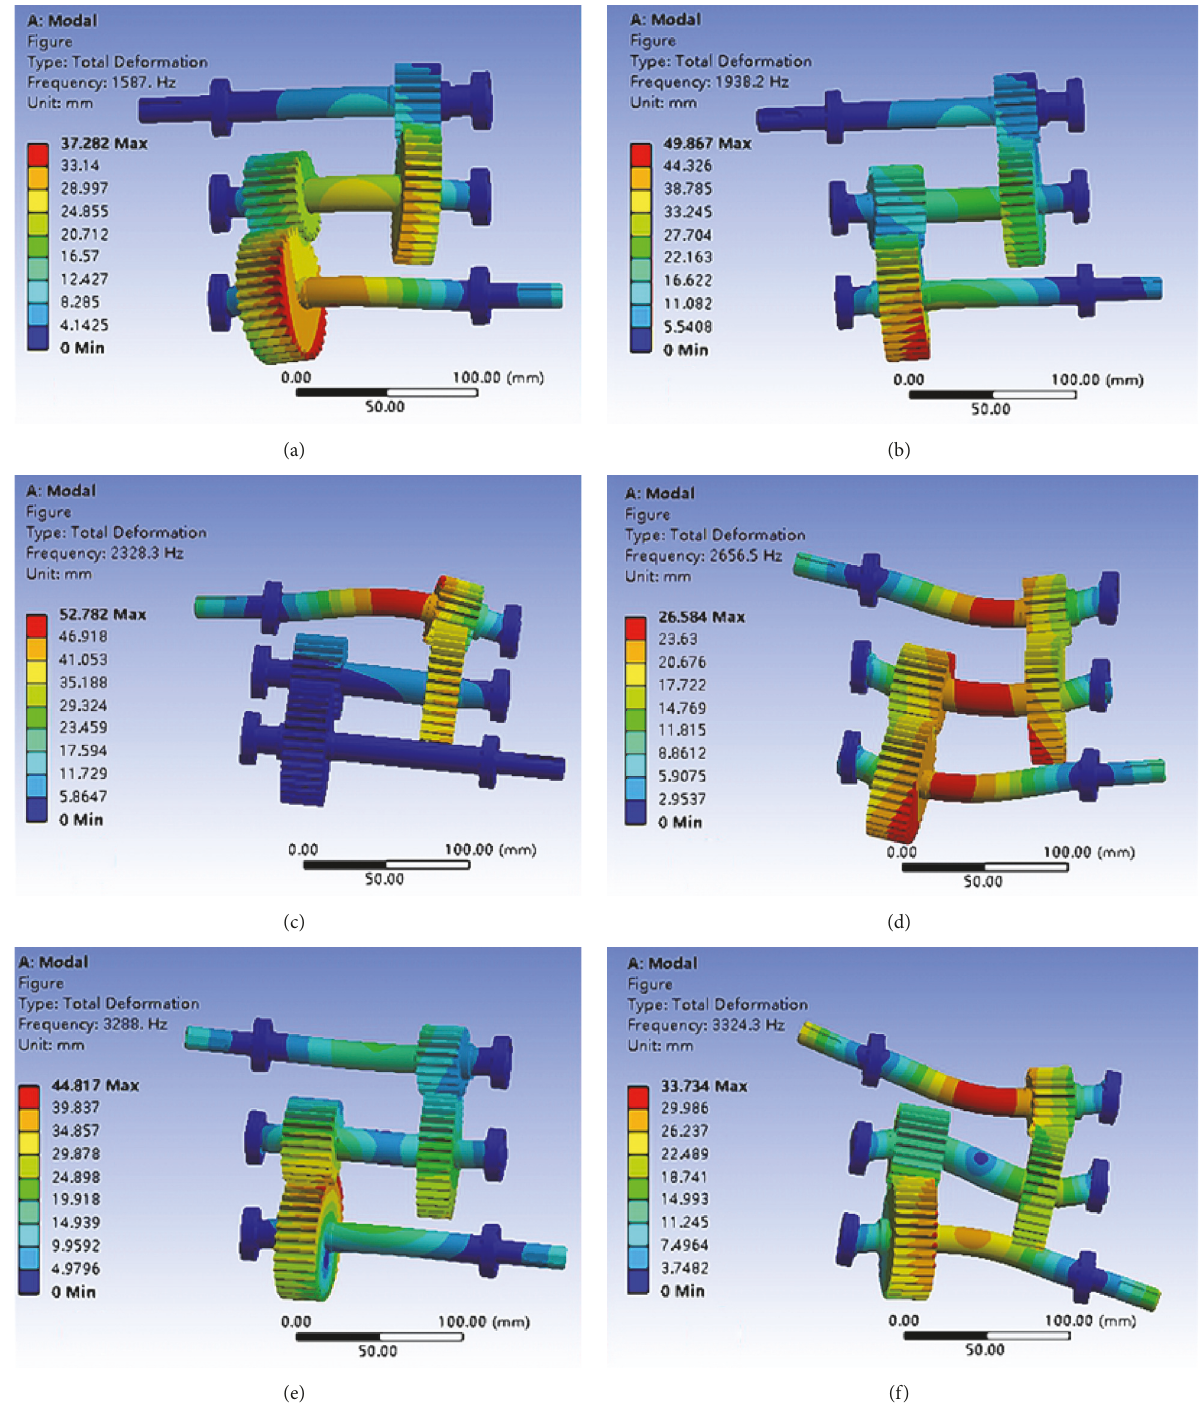
Figure 4: The preceding six-order modal shapes of MGTS.